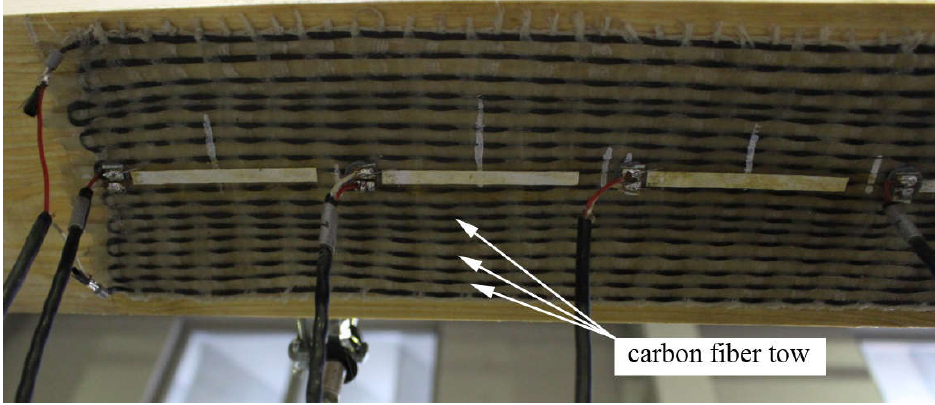
Figure 1. The second generation of the textile sensor, adhered to a specimen of timber.